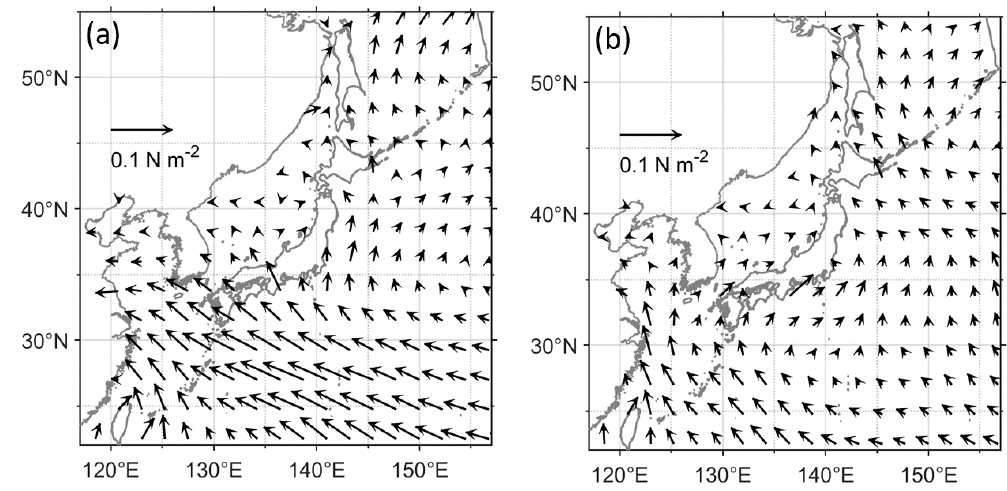
Figure 5. Surface wind stress (black vector) in August averaged for periods ( a ) H and ( b ) L. There are strong (weak) west-northwestward wind stresses around 136 ◦ E and 29 ◦ N (140 ◦ E and 28 ◦ N) in the south of the NEAMS for the period H (period L). Coastlines are drawn in grey.